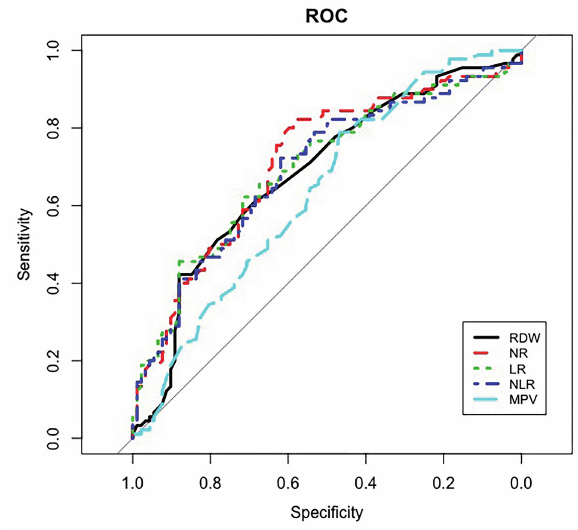
Figure 1 - Optimal cut-off values and ROC analyses for LR, NR, RDW, MPV and